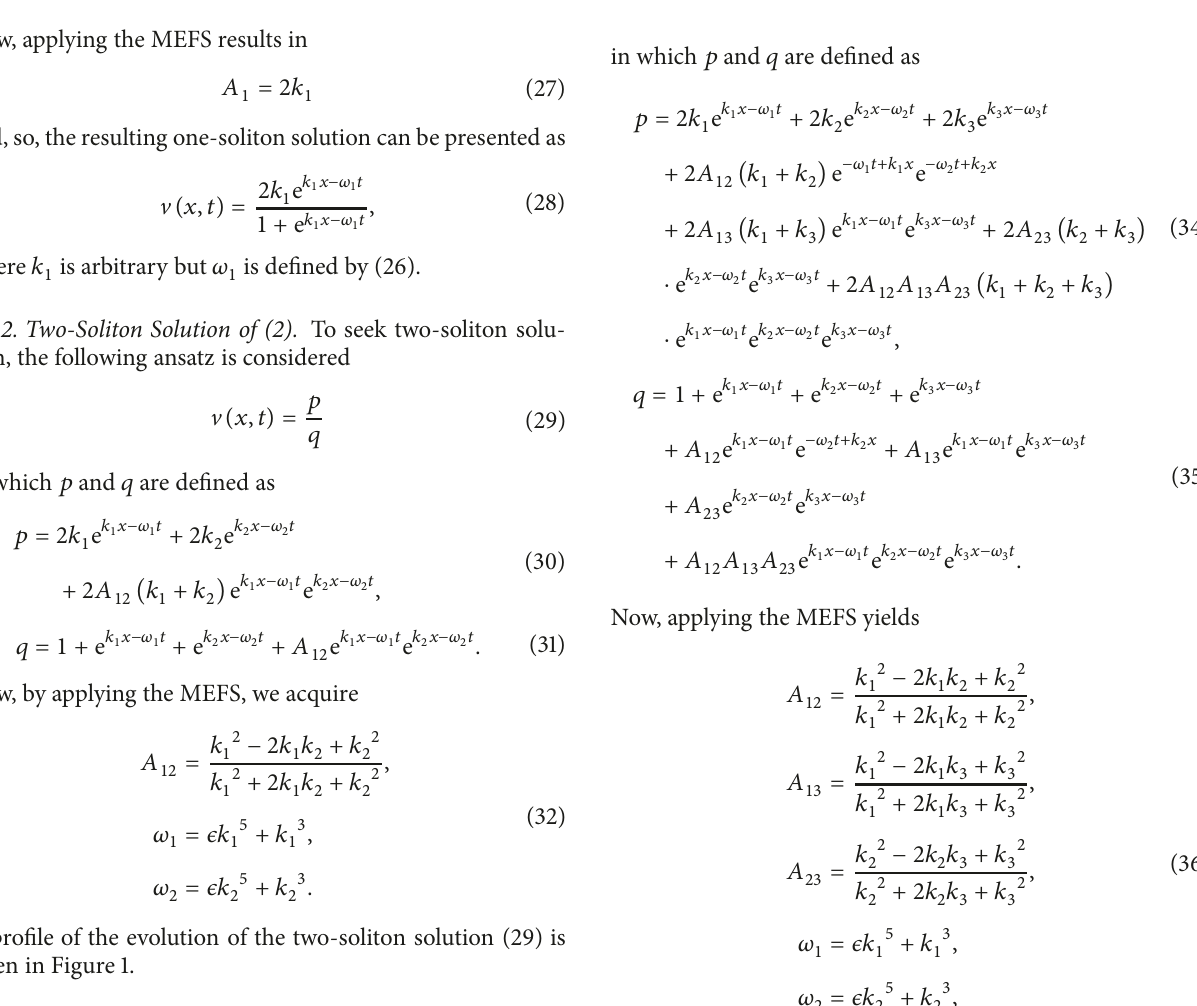
Figure 2: Evolution of the three-soliton solution